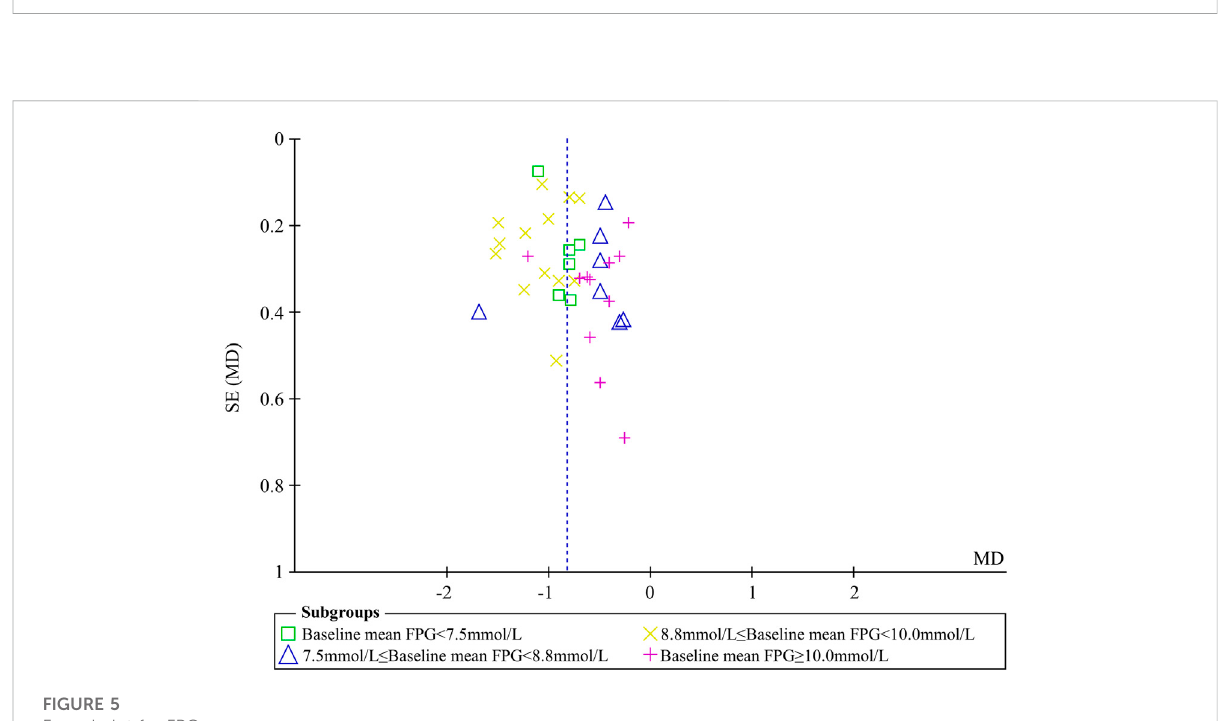
FIGURE 5 Funnel plot for